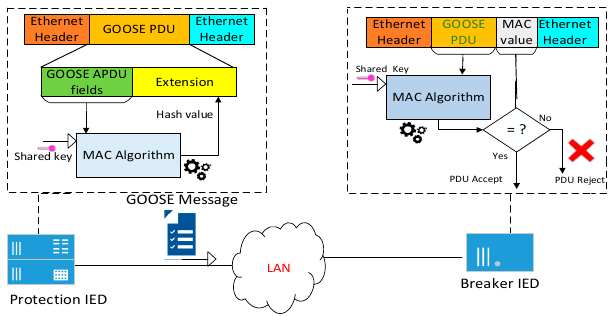
Figure 8. HMAC integration to GOOSE messages for secure communication.